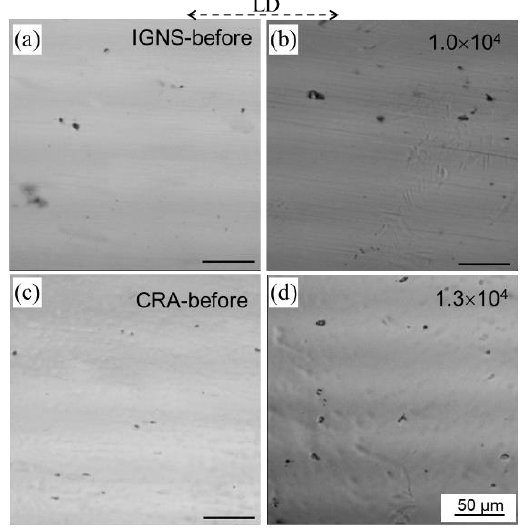
Figure 11. Surface morphology of the IGNS sample ( a ) before and ( b ) after cyclic deformed to 1.0 × 10 4 , compared with the CRA sample ( c ) before and ( d ) after cyclic deformed to 1.3 × 10 4 at a stress amplitude of 700 MPa.